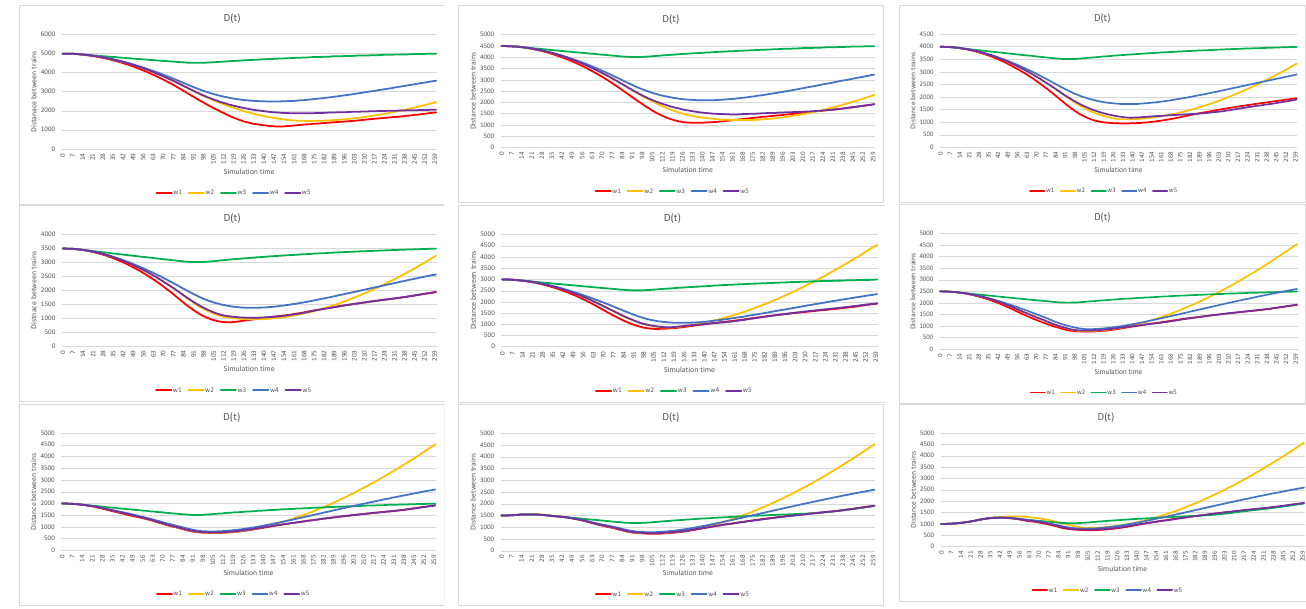
Figure 15. Summary of distance curves D ( t ) for D 0 = 5000, 4500, 4000, 3500, 3000, 2500, 2000, 1500, 1000 (m) in simulation for context 3.